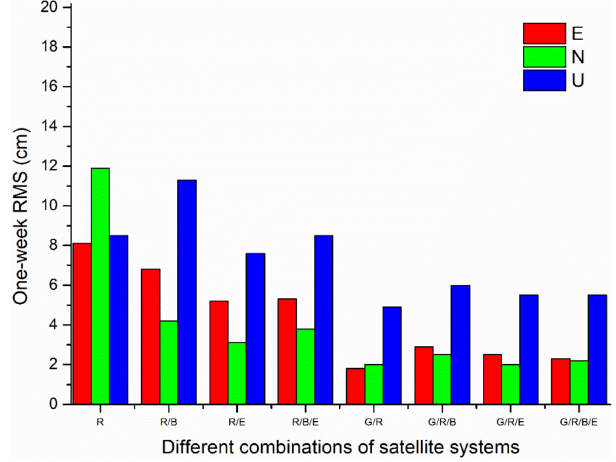
Figure 10. Positioning accuracy of different combined solutions for the EG model in kinematic